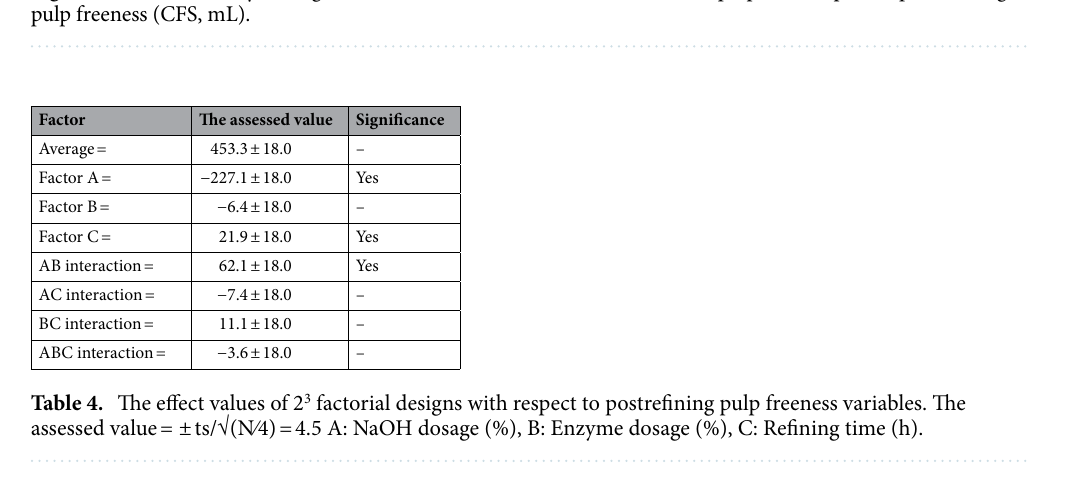
Figure 5. Factorial analysis diagram of rice straw semi-chemical mechanical pulp with respect to postrefining pulp freeness (CFS, mL).